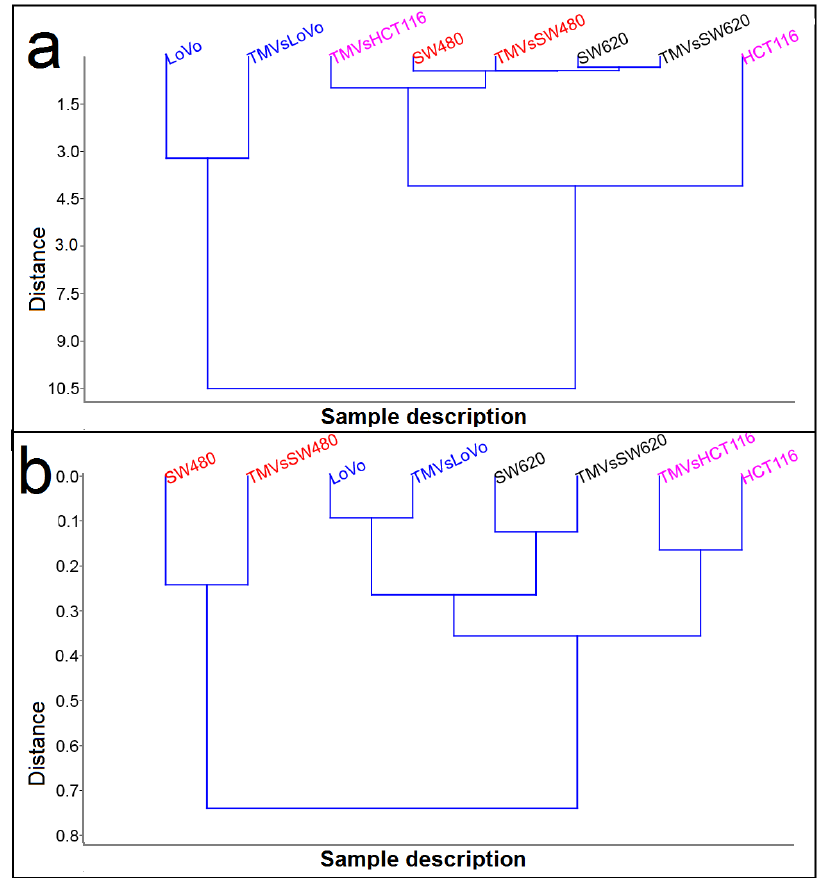
Figure 7. Hierarchical cluster analysis (HCA) of HCT116, LoVo, SW480, and SW620 cell lines and their